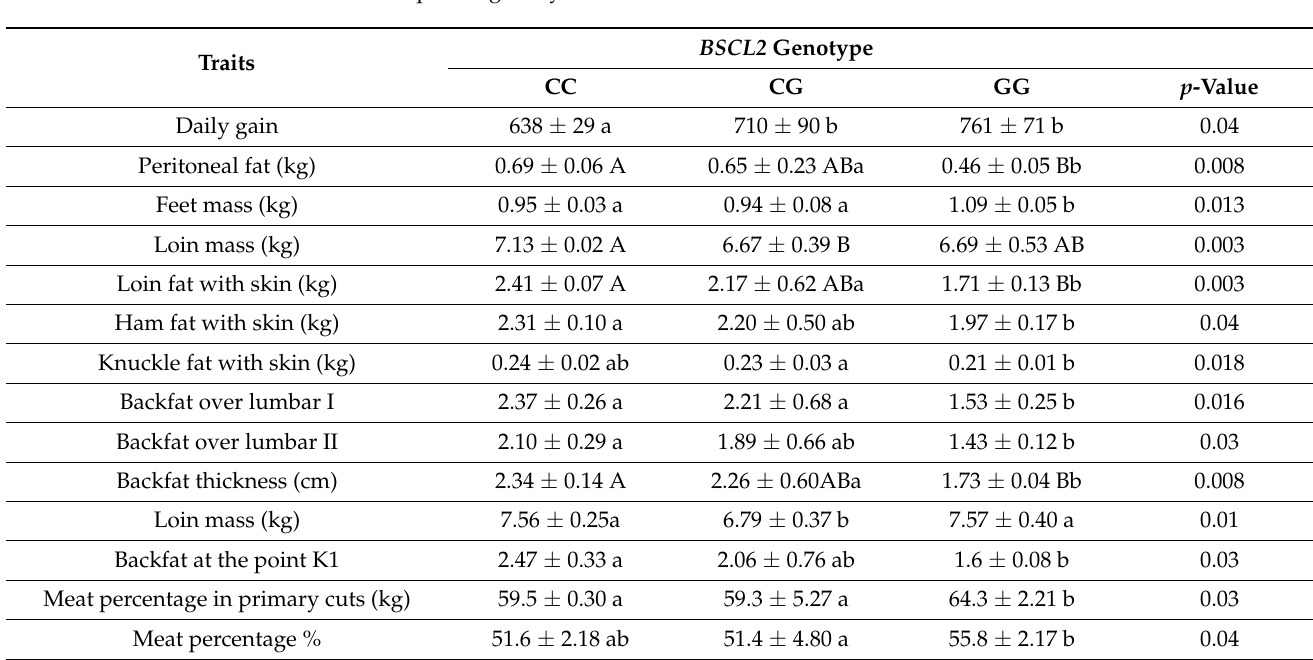
Table 4. Means with standard deviation (SD), calculated based on ANOVA test (SAS) for pig production traits dependent on rs81333153 BSCL2 variant, for 16 Złotnicka White pigs included in RNA sequencing